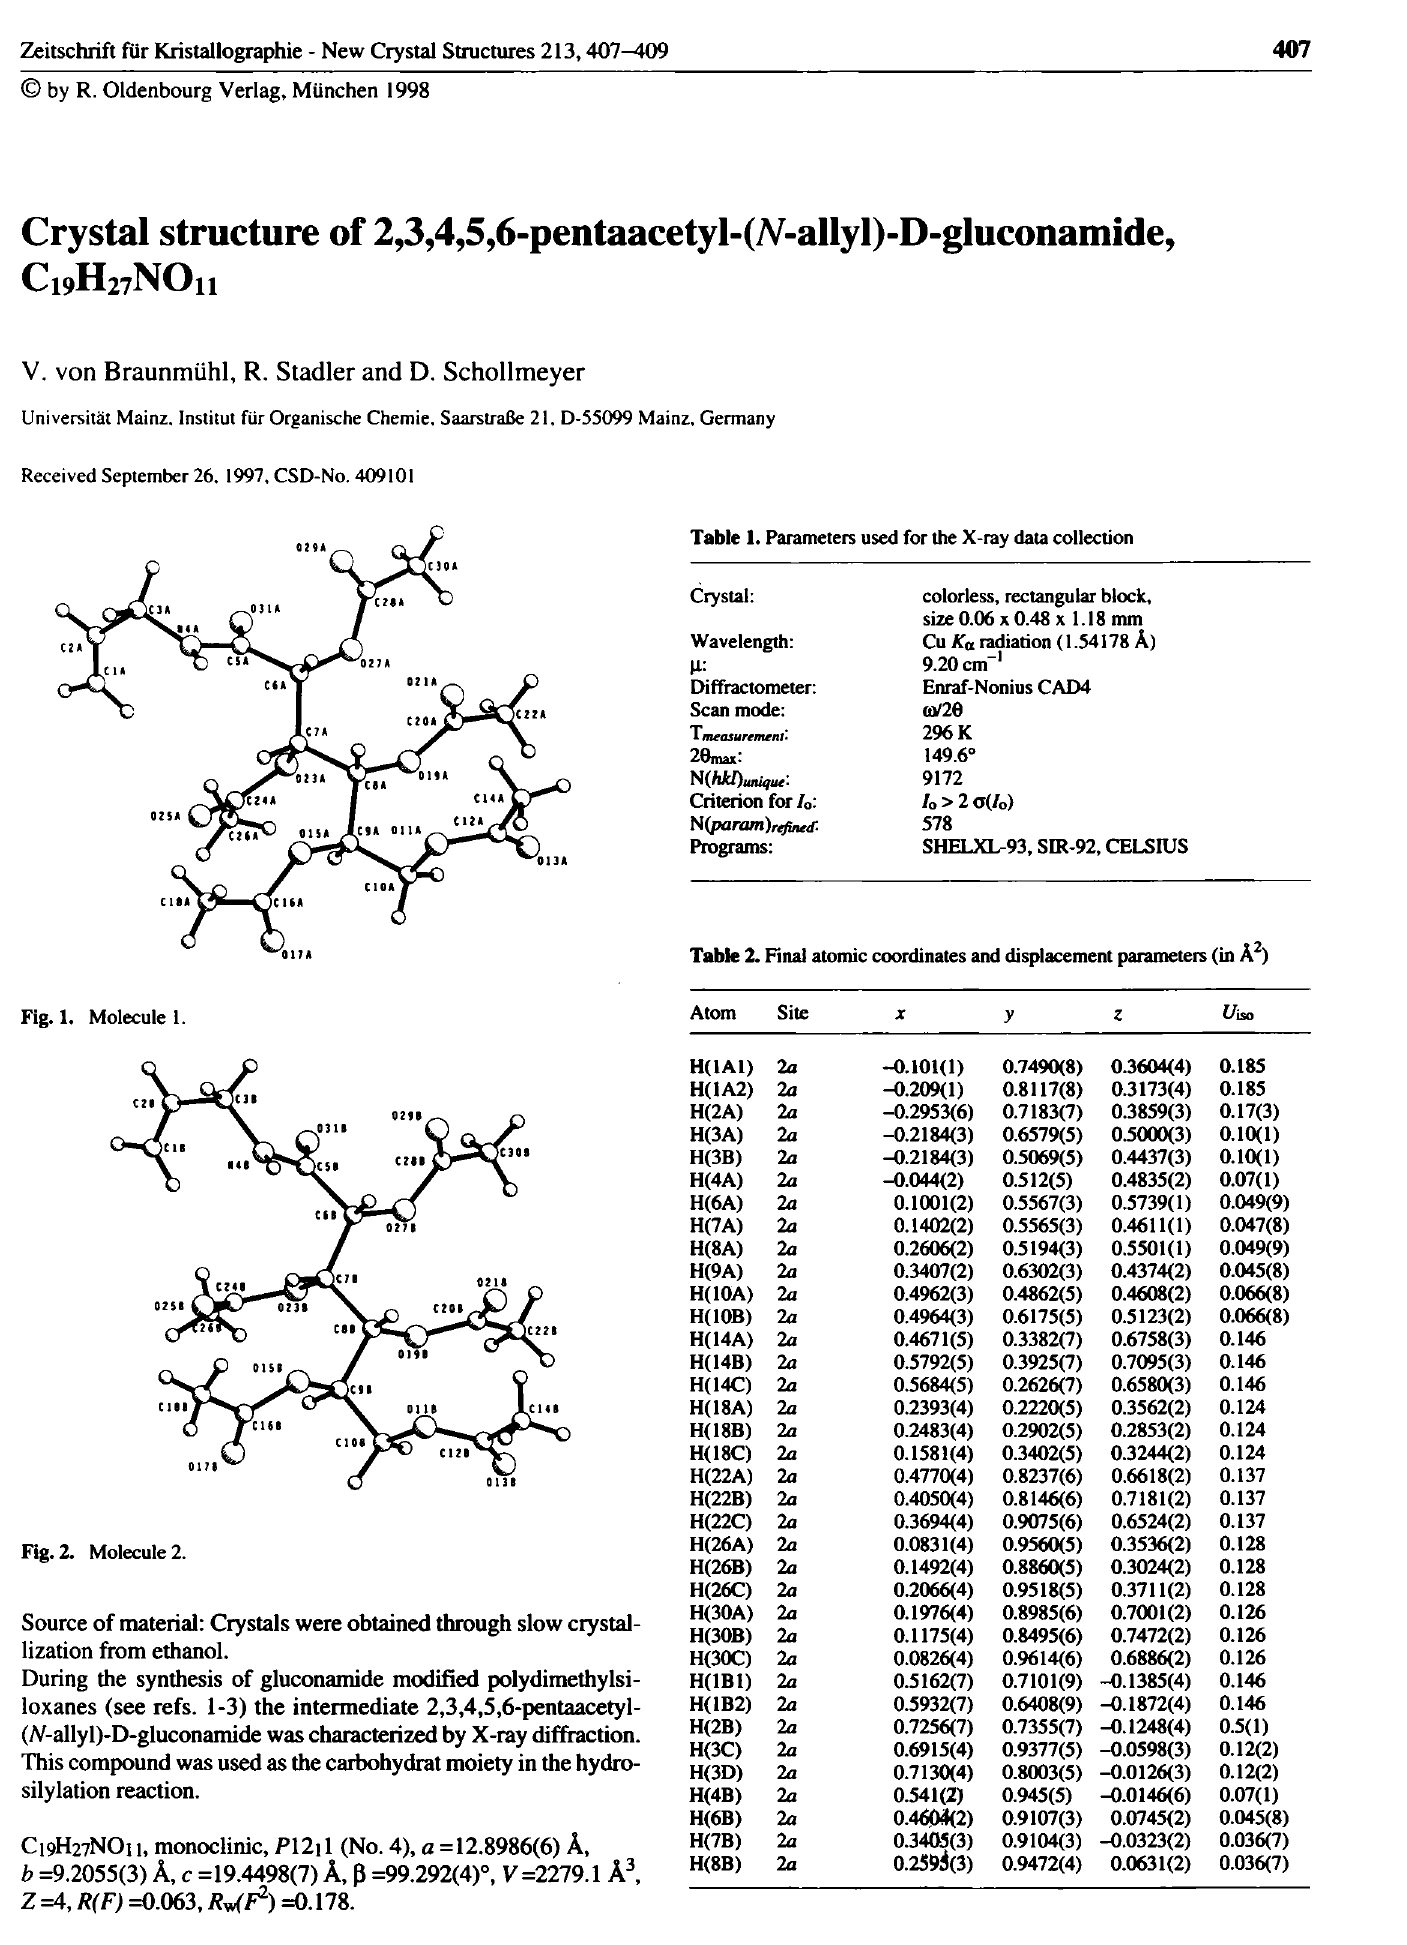
Table 1. Parameters used for Üie X-ray data collecüon